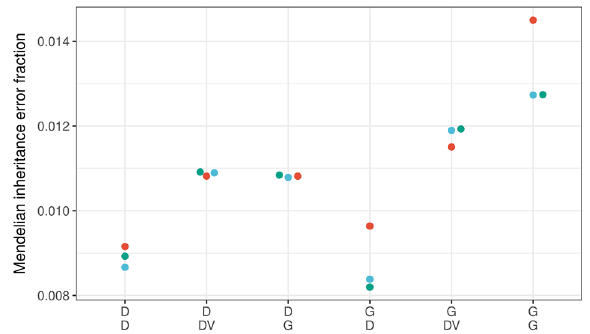
Figure 7. Mendelian inheritance error fractions. The GIAB trio consists of the genome in a bottle samples HG002, HG003, and HG004. They were sequenced three times, and Mendelian inheritance error fractions were estimated for chromosomes 20–22. Each dot represents the Mendelian inheritance error fraction for one trio. Labels on the x-axis are defined in detail in Fig.